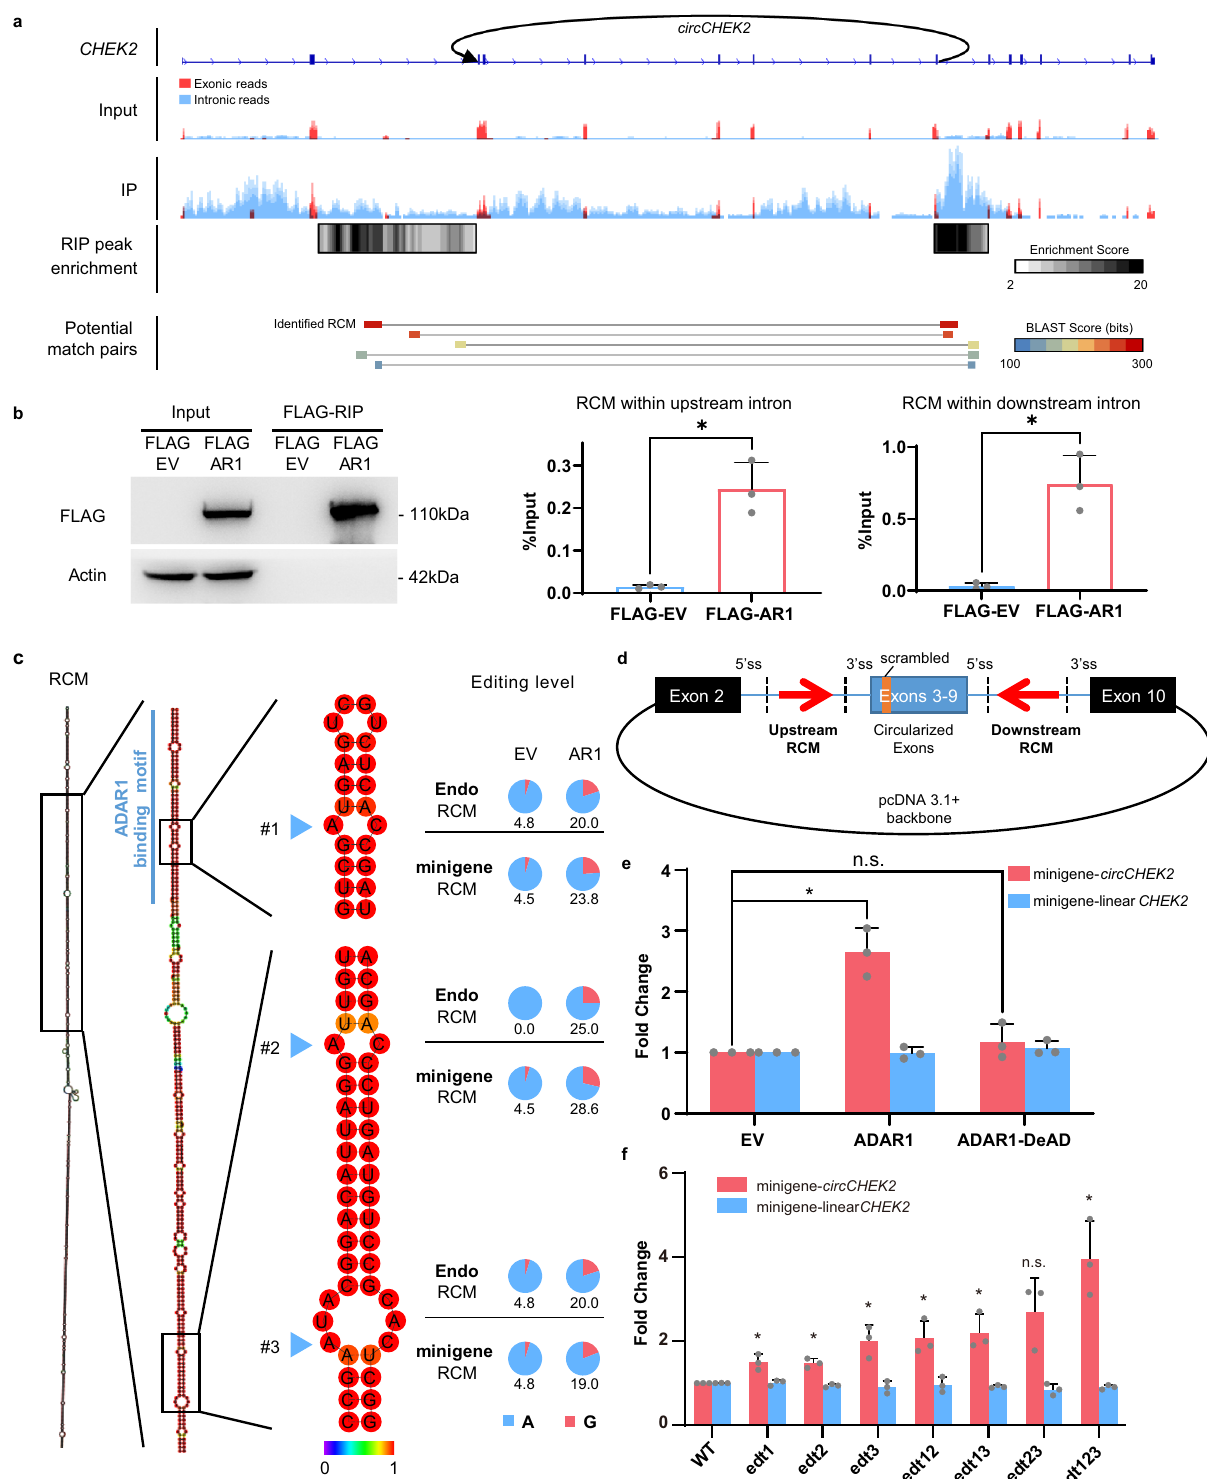
editing sites are involved in such regulation, we introduced an A- to-G mutation into the minigene at each editing site to mimic a fully edited site. Intriguingly, each single, double, or triple combination of these mutations led to increased expression of minigene- circCHEK2 (Fig. 3f). Of note, these three editing sites demonstrated synergistic effect on promoting circCHEK2 biogen- esis (Fig. 3f). Collectively, ADAR1-mediated editing of RCMs can promote circCHEK2 biogenesis. NATURE COMMUNICATIONS| (2022) 13:1508